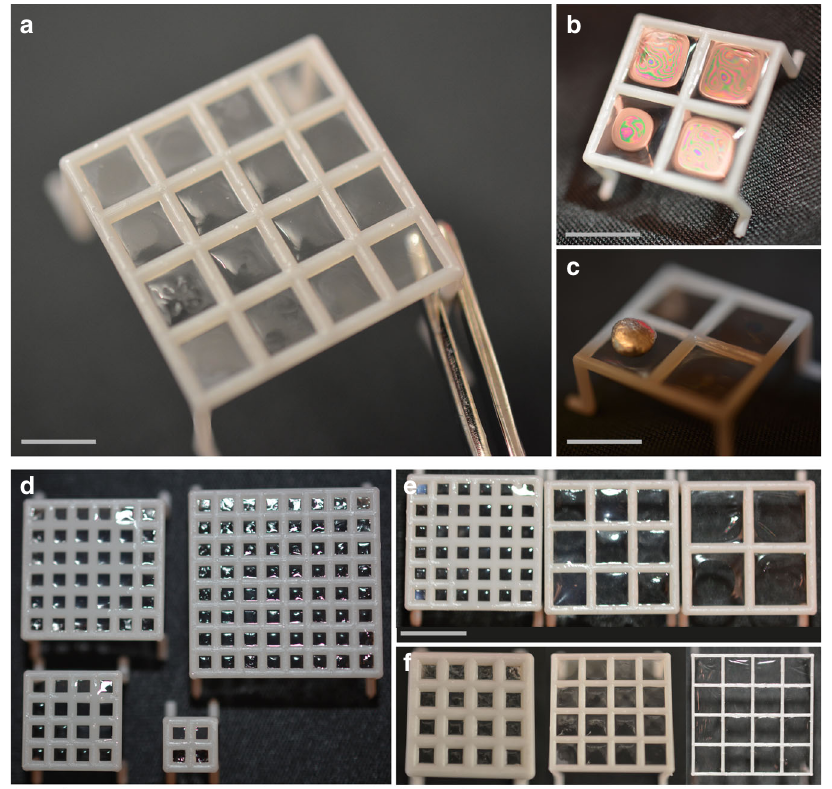
Fig. 2 Tunable design parameters. a Flat scaffolds were coated with 7.5 wt% methacrylated gelatin that was photopolymerized (0.5 wt% LAP; λ = 365 nm; I = 6 mWcm − 2 ; t = 120 s) to form solid fi lms across the device windows. Scale bar, 2.5 mm. b , c After polymerization, a load-bearing fi lm was formed 0 across the device windows. Scale bars, 5 mm. d The coating process was scalable to larger surface areas (scaffolds of 0.5 × 0.5 cm, 1 cm × 1 cm, 1.5 cm× 1.5 cm, and 2 cm × 2 cm) in the same amount of fabrication time for the coating step. Scale bar, 5 mm. e Scaffolds with varied window sizes (2.25, 5.5, and 8.75 mm) were coated. Scale bar, 5 mm. f . Scaffolds with different pipe diameters (1, 0.5, and 0.25 mm) were coated. Scale bar, 5